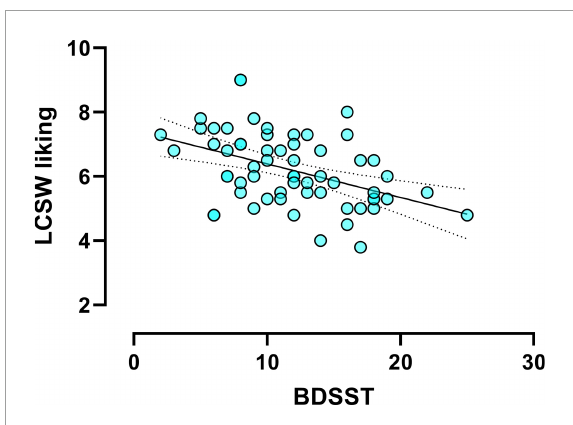
total score was significantly correlated to PSS ( r = 0.39, p =